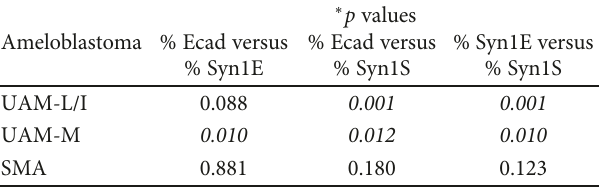
Table 3: Di ff erences in expression among UAM-L/I, UAM-M, SMA, and E-cadherin and syndecan-1 expression.